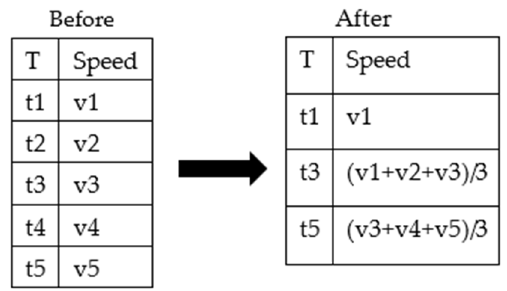
Figure 3. Principle of data thinning.